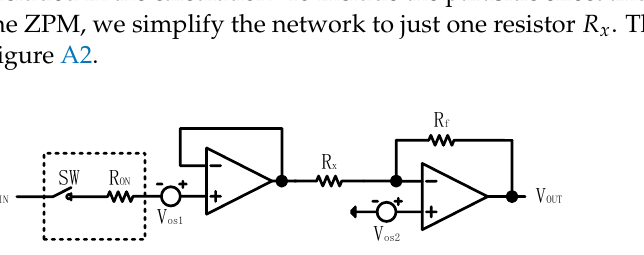
Figure A2. Circuit designs that include parasitic effects in the cases of ZPM .